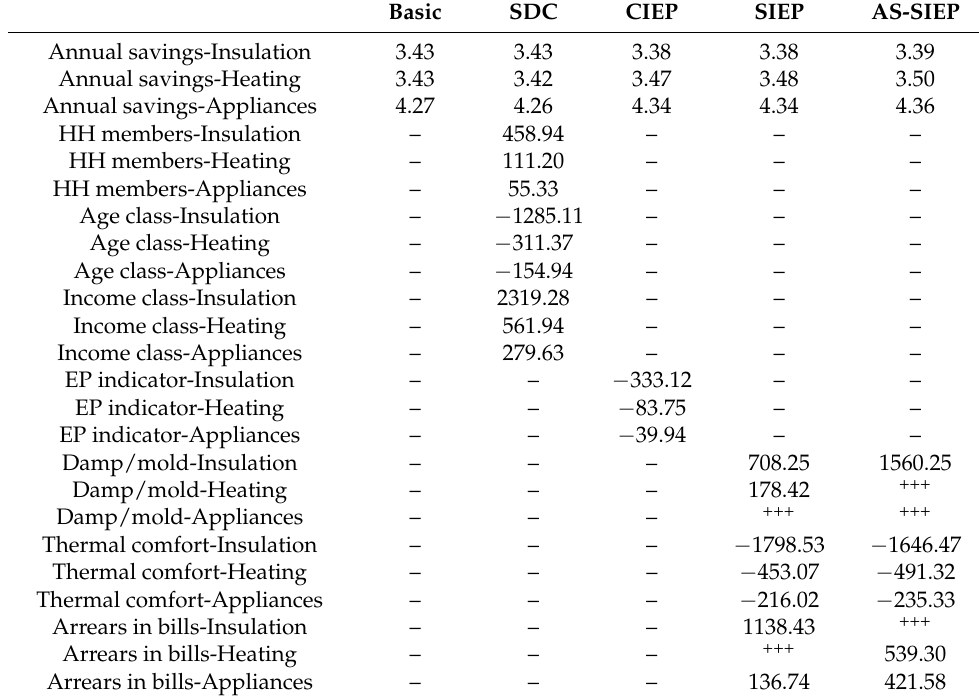
Table 4. Marginalwillingness-to-pay(MWTP)estimatesfortheBasic,